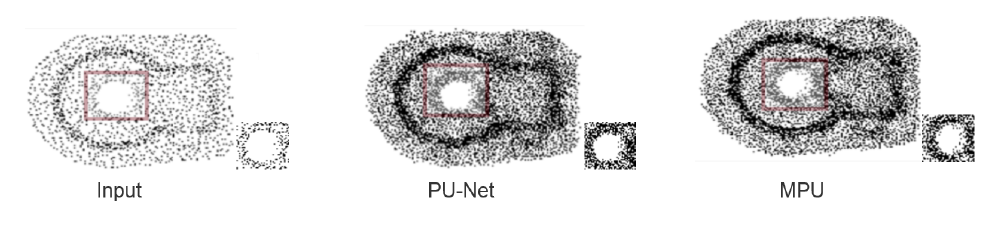
Figure 19. Input and GT point cloud.